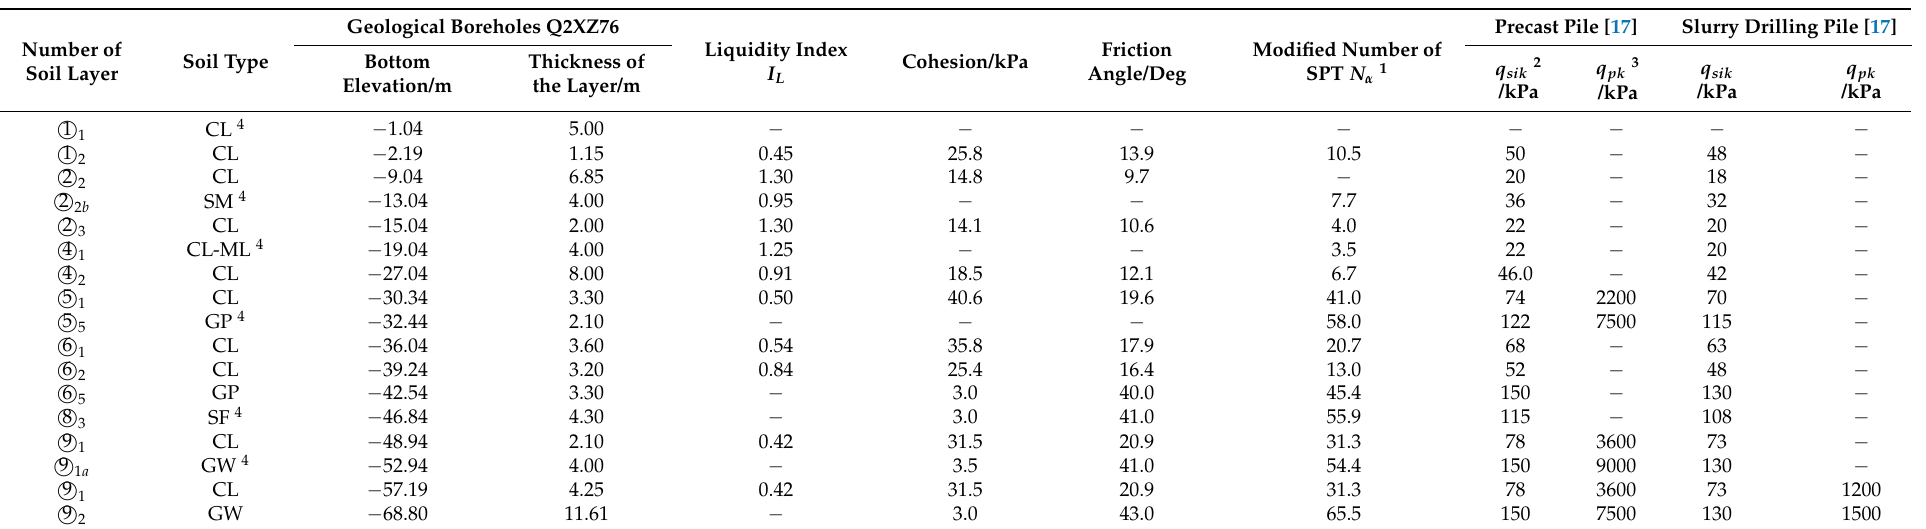
Table 2. Parameters of the geological